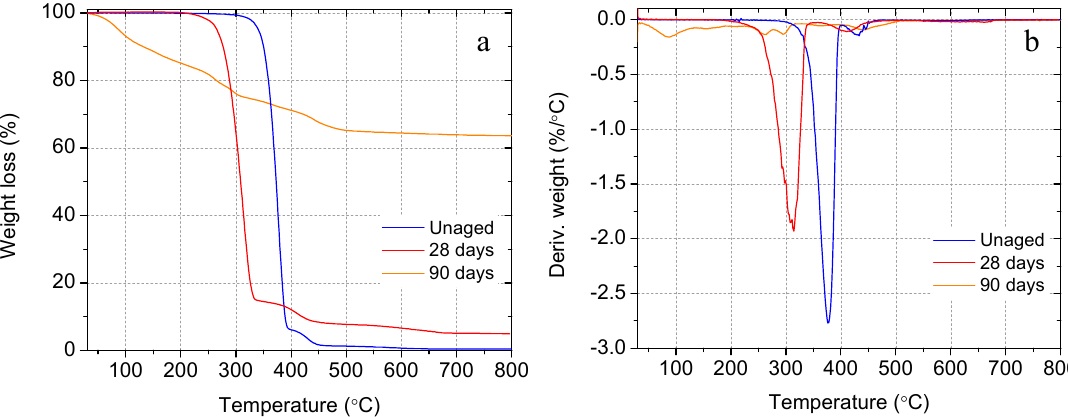
Figure 9. Comparison of unaged PLA and after degradation in concrete cured inside saturated lime solution at 23 °C for different ages: ( a ) thermogravimetric weight loss, and ( b ) derivative of weight loss. Table 4. Degradation of PLA capsules in the matrices of concrete, mortar and cement paste under different curing conditions.